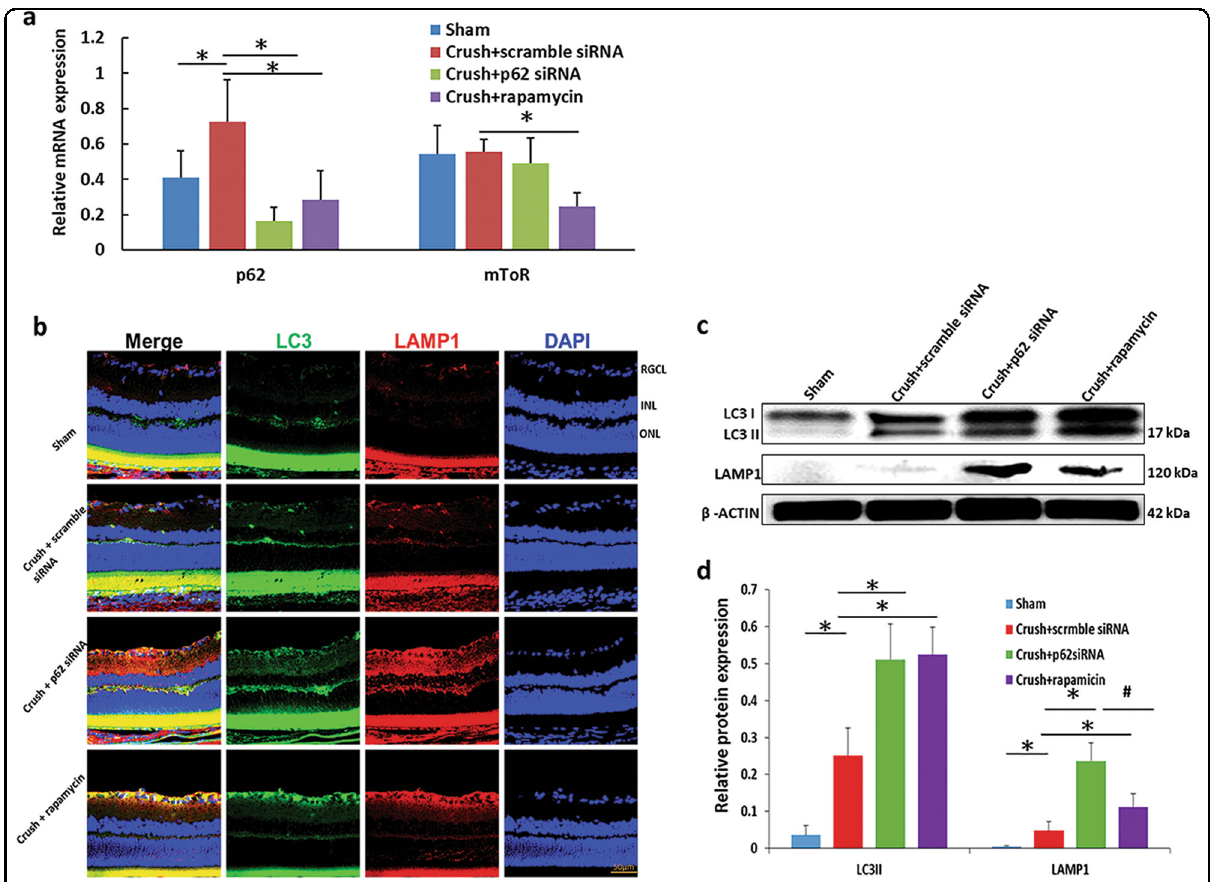
Fig. 1 Con fi rmation of autophagy induction after treatment with p62 siRNA or rapamycin. a mRNA levels of p62 and mTOR in the retina tissue for each group ( n = 6). Both autophagy inducers reduced the mRNA level of p62 but only rapamycin reduced mRNA mTOR expression. b Immunostaining for LC3 and LAMP1 expression in the retinal section to evaluate autophagy induction. Treatment with either p62 siRNA or rapamycin induced a higher level of LC3 and LAMP1 than did treatment with scrambled siRNA. c Protein expression levels of LC3 II and LAMP1 in the retina. Representative results from three independent experiments are shown. d Quantitative analysis of the level of LC3 II and LAMP1 normalized to the internal control, beta-actin. The levels of LC3-II and LAMP1 in retinas were increased in the p62-siRNA-treated group and the rapamycin-treated group compared with those in the scrambled siRNA-treated group. Treatment with p62 siRNA induced more LAMP1 expression than did treatment with rapamycin. * P < 0.05 indicates scrambled siRNA-treated group versus other groups; # P < 0.05 indicates the P62--siRNA-treated group versus rapamycin-treated group. RGCL retinal ganglion cell layer, INL inner nuclear letter, ONL outer nuclear